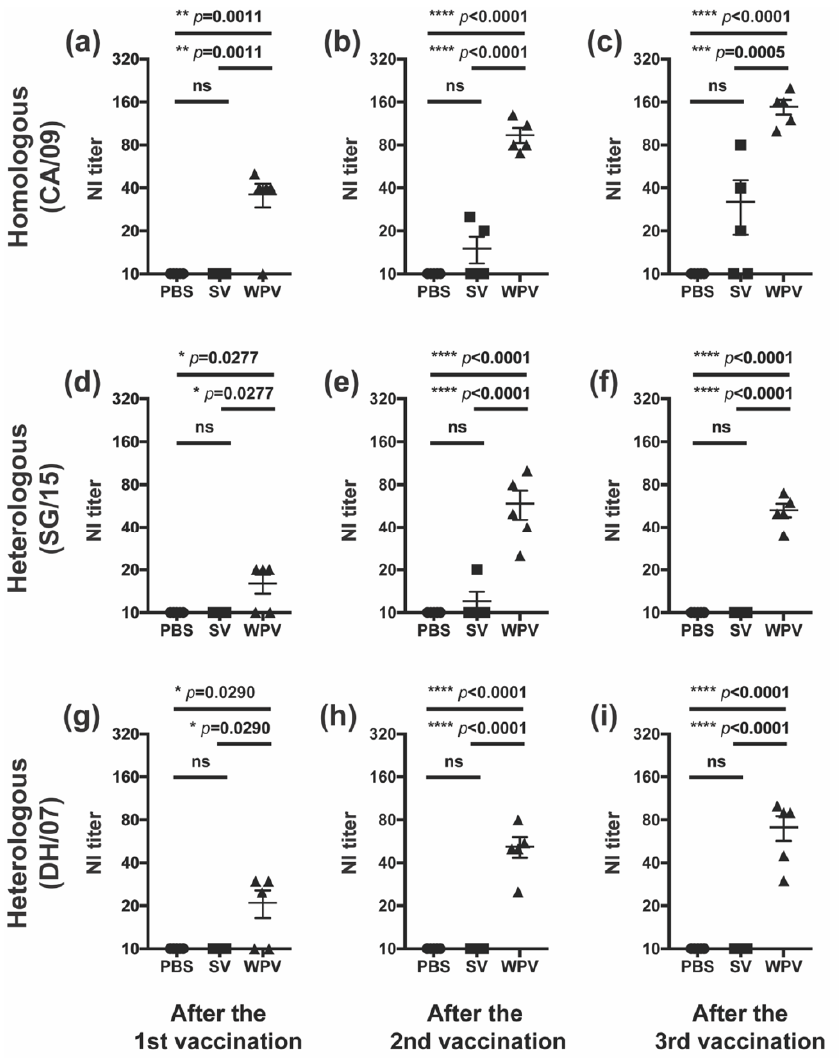
Figure 3. NI antibody titers after vaccination with WPV or SV. C57BL/6 mice were subcutaneously vaccinated three times at 21-day intervals with 9 µg of protein of monovalent CA/09 WPV or SV, as shown in Figure 2a. NI antibody titers against homologous CA/09 ( a – c ) and heterologous SG/15 ( d – f ) and DH/07 ( g – i ) were evaluated in serum samples collected on days 19 ( a , d , g ), 41 ( b , e , h ), and 52 ( c , f , i ). Dots represent individual values, and the mean values with SEM are indicated by lines ( n = 5 per group). The circles, squares, and triangles indicate data from mice inoculated with PBS, SV, and WPV, respectively. * p < 0.05, ** p < 0.01, *** p < 0.001, **** p < 0.0001, one-way ANOVA using a multiple-comparison correction; ns indicates not significant ( p > 0.05).